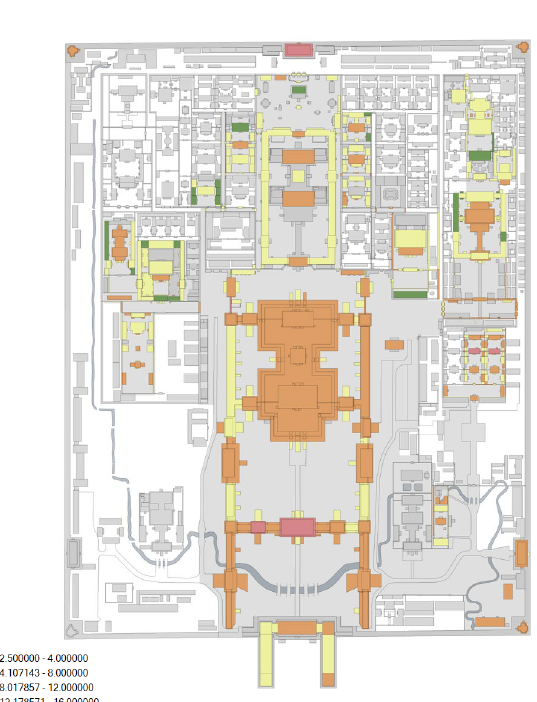
Figure 7. The overall deterioration condition of masonry.